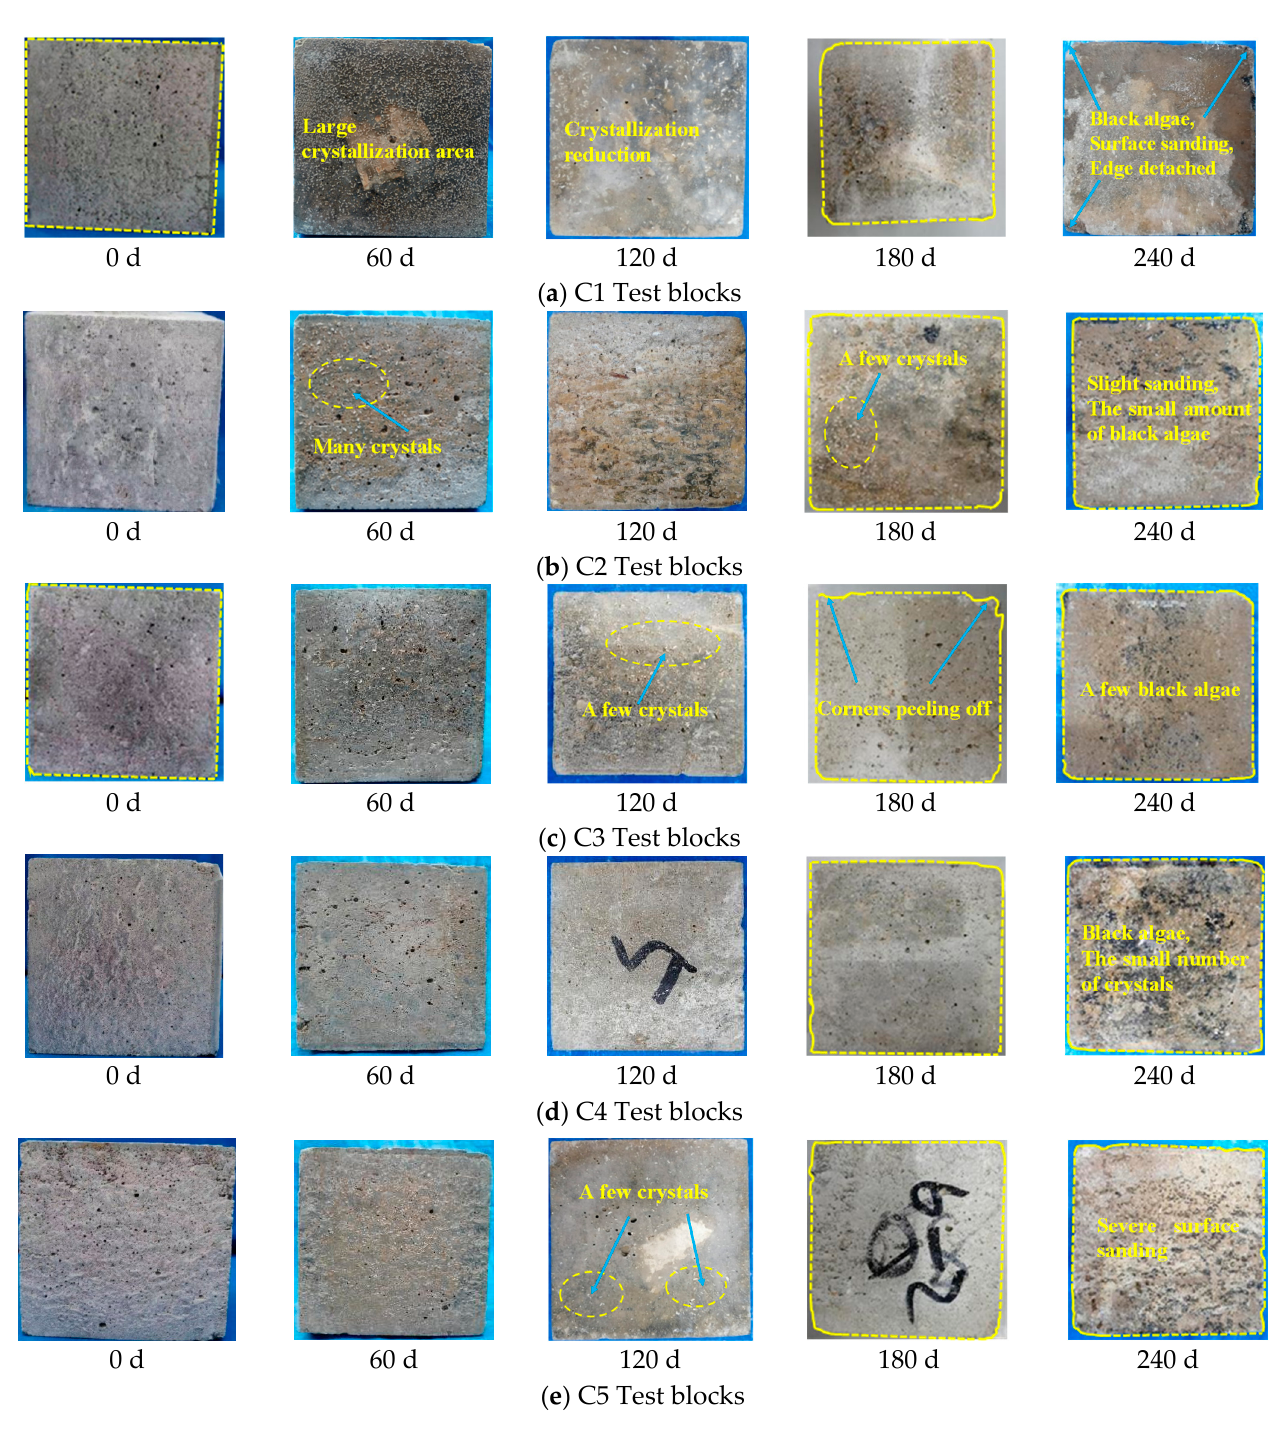
Figure 1. Concrete corrosion phenotypes.